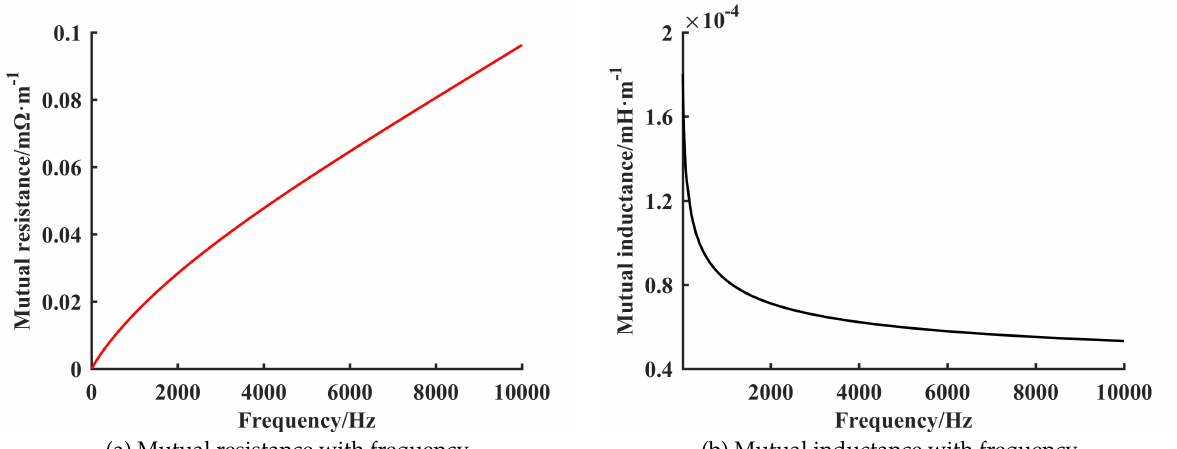
Fig. 11. Variation of rail mutual impedance with frequency.